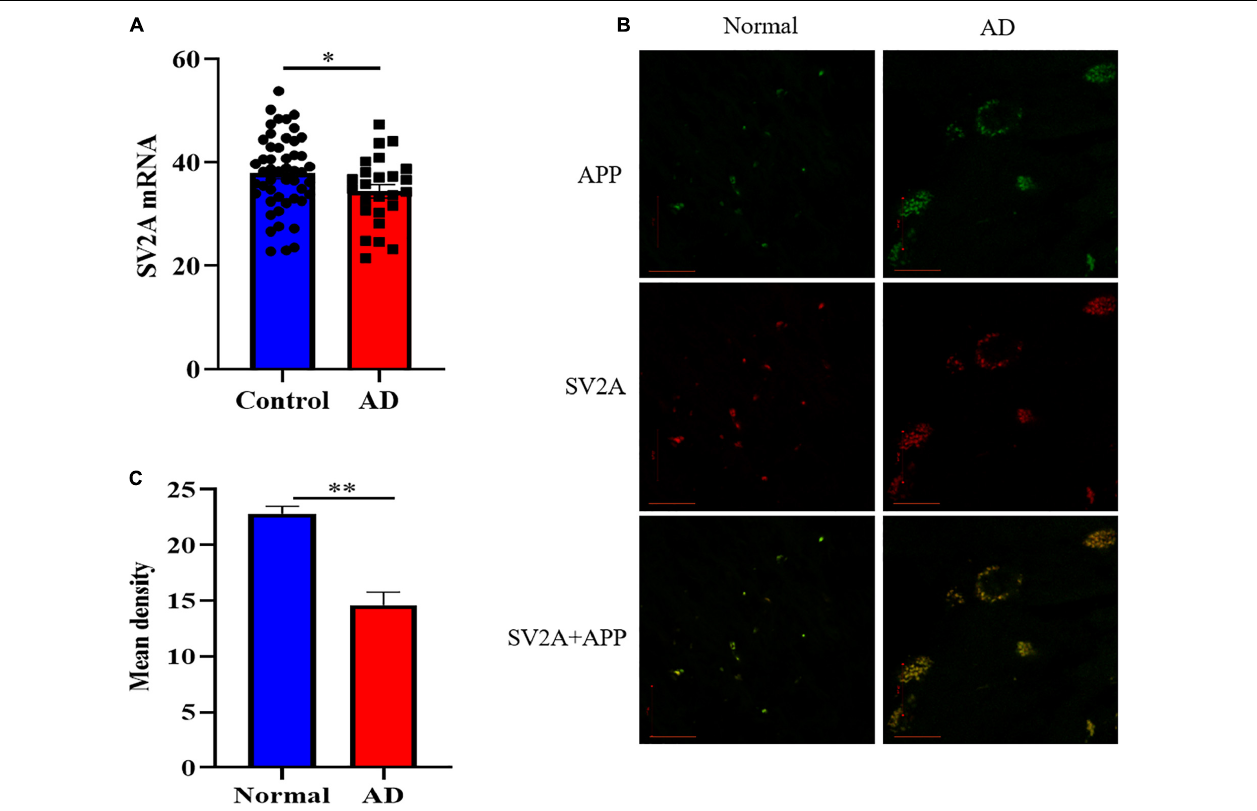
FIGURE 1 | SV2A expression decreased and its pattern changed in AD patients. (A) Comparation of relative SV2A mRNA expression levels in the hippocampus of non-AD patients and AD patients. The expression level was normalized to the mean expression level of non-AD patients. Data come from the Allen Brain database. For non-AD patients and AD patients, n = 50 and 25, respectively. (B) Immunofluorescence observation of APP (green) and SV2A protein (red) in the hippocampus of non-AD patients and AD patients reveals a change in the morphology of SV2A protein and a colocalization of APP and SV2A protein in the hippocampus of AD patients. Scale bar, 20 µ m. (C) Quantitation of the mean density of SV2A staining in normal and AD brain sections. Data are expressed as mean ± SEM. One-way analysis of variance (ANOVA). ∗ p < 0.05. ∗∗ p <